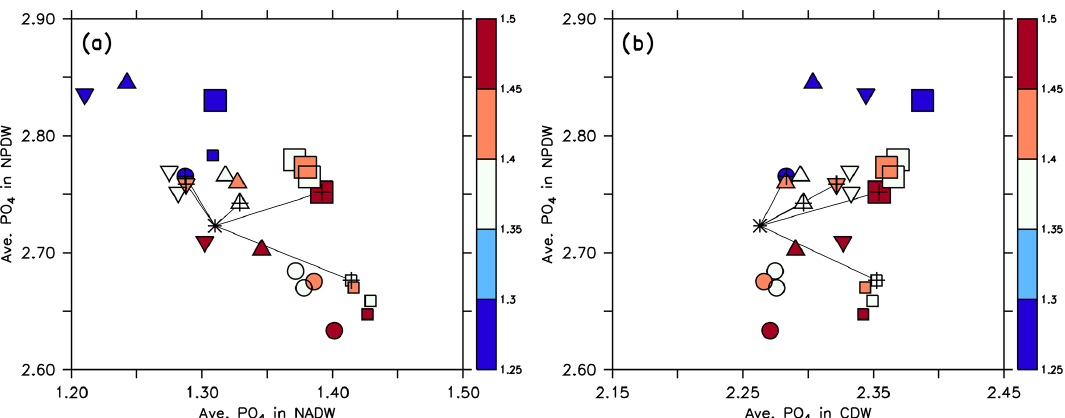
Figure 8. Average phosphate in the northern North Pacific Deep Water (NPDW; between 0 and 60 ◦ N at 1500–5000m; see Sect. 2.3) plotted against average phosphate in the northern North Atlantic Deep Water (NADW; between 0 and 60 ◦ N at 1500–2500m; a ) or Circumpolar Deep Water (CDW; south of 45 ◦ S, 1500–5000m; b ), of all 25 model experiments. Small squares: MIT28 circulation. Large squares: ECCO circulation. Circles: UHigh circulation. Triangles: U20 circulation. Inverted triangles: U17.5 circulation. (See also symbol legend in Fig. 6.) The colour indicates the value of parameter b . Pluses indicate the optimal parameter set. Stars indicate observed values. Thin black lines extending from the stars denote the distance between observation and each optimal model configuration.